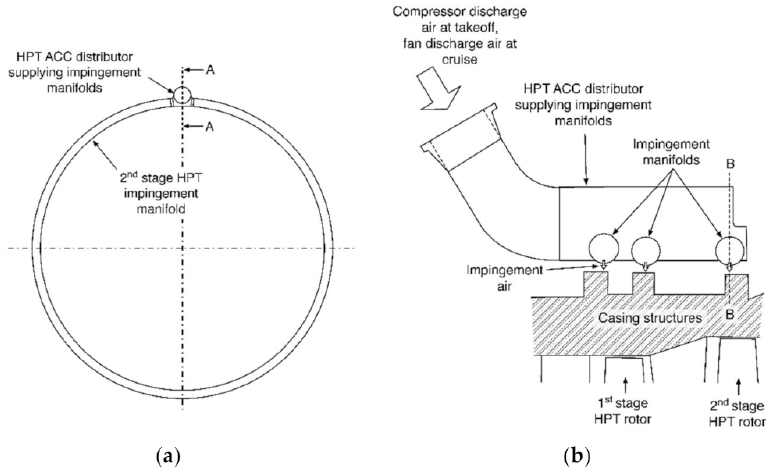
Figure 2. ( a ) Axial plane through the HPT ACC single-entry impingement feed system of the GE CF6-6 engine. Figure adapted from [4]. Position of axial plane is shown in ( b ) (B-B). ( b ) Meridional plane through HPT ACC system of the GE CF6-6 engine. Figure adapted from [4]. Position of meridional plane is shown in ( a )